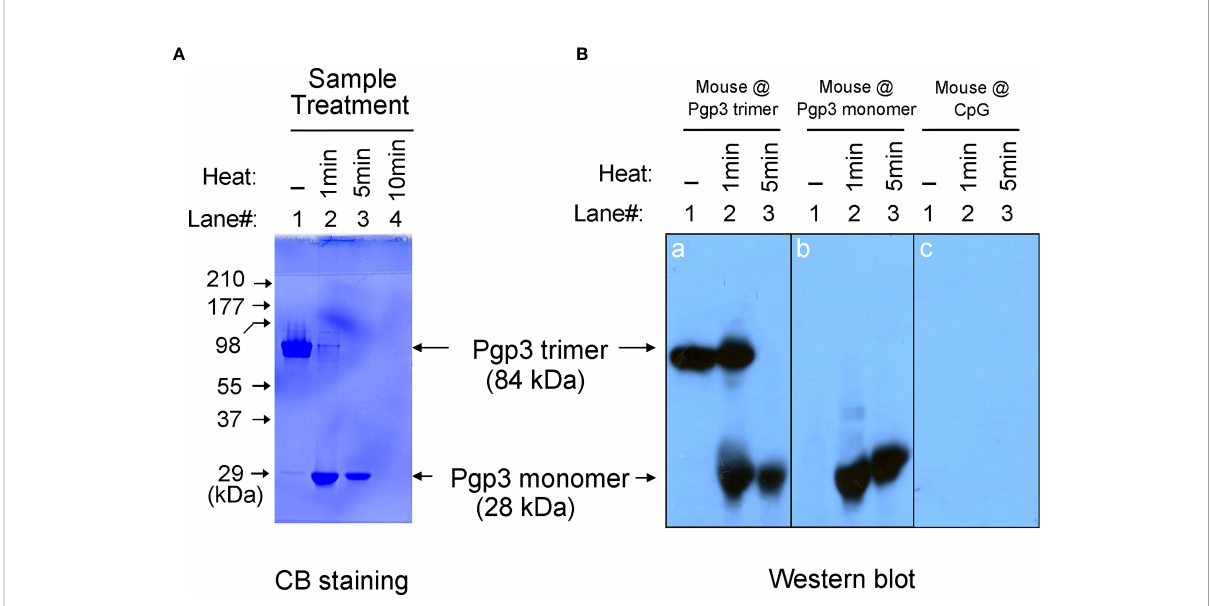
FIGURE 1 Pgp3 proteins used in this study and their immunogenic analysis. (A) Untreated Pgp3 protein and Pgp3 protein boiled for 1, 5, or 10 min were loaded in a 12% native gel and stained with Coomassie blue dye. (B) Untreated Pgp3 protein and Pgp3 protein boiled for 1 or 5 min were loaded in gels for western blot detection with sera immunized with Pgp3 trimer (panel a ), Pgp3 monomer (panel b ), or CpG alone (panel c